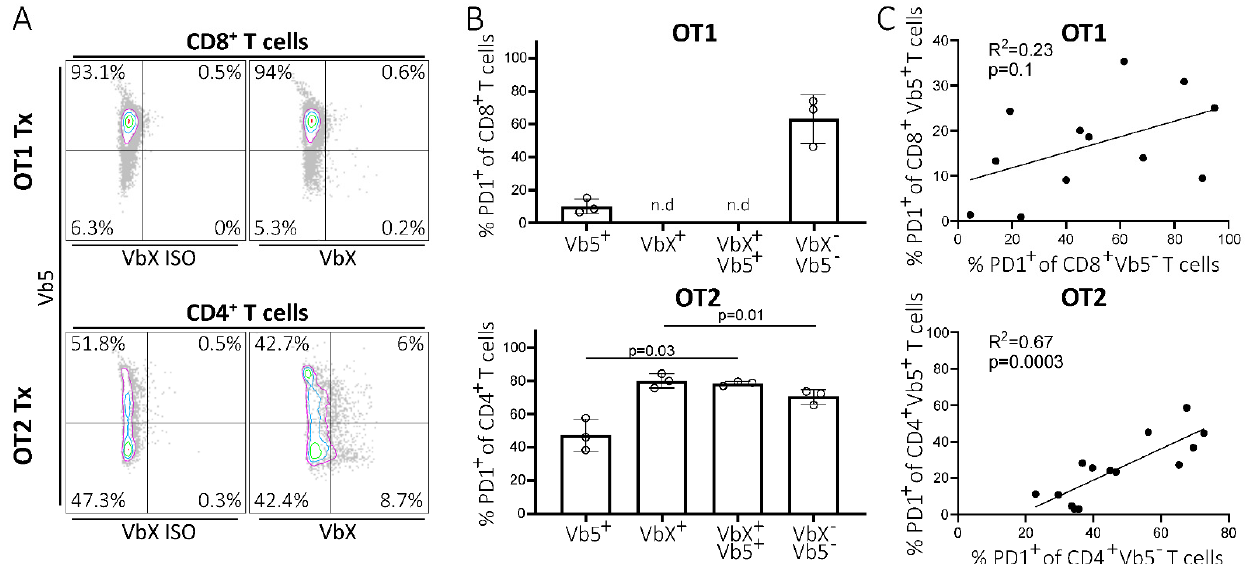
Figure 2. Non-cancer-specific T cells upregulate PD1 after CLL transplantation. ( A ) Representative flow cytometry data of splenocytes of transplanted OT1/OT2 mice stained with a FITC-conjugated antibody cocktail targeting various TCR Vb chains (VbX) and a PE-conjugated antibody recognizing the OVA-specific TCR (Vb5). The VbX antibody cocktail recognizes around 71% of all endogenous TCR Vb chains of a WT mouse. Thus, Vb5neg VbXneg populations represent endogenous T cells expressing single TCR Vb chains not covered by the VbX antibody cocktail. The left panel represents an isotype control for VbX, the right panel shows the actual VbX signal. ( B ) PD1pos T cell fractions of OT1/OT2 mice ( n = 3), of the flow cytometry quadrants depicted in A. Populations consisting of <100 events were not analyzed. P values are only shown when significant. Error bars represent SD. ( C ) Correlation of PD1pos T cell fraction in Vb5pos and Vb5neg T cell populations in OT1/OT2 mice. n.d.: not detected, SD: standard deviation.